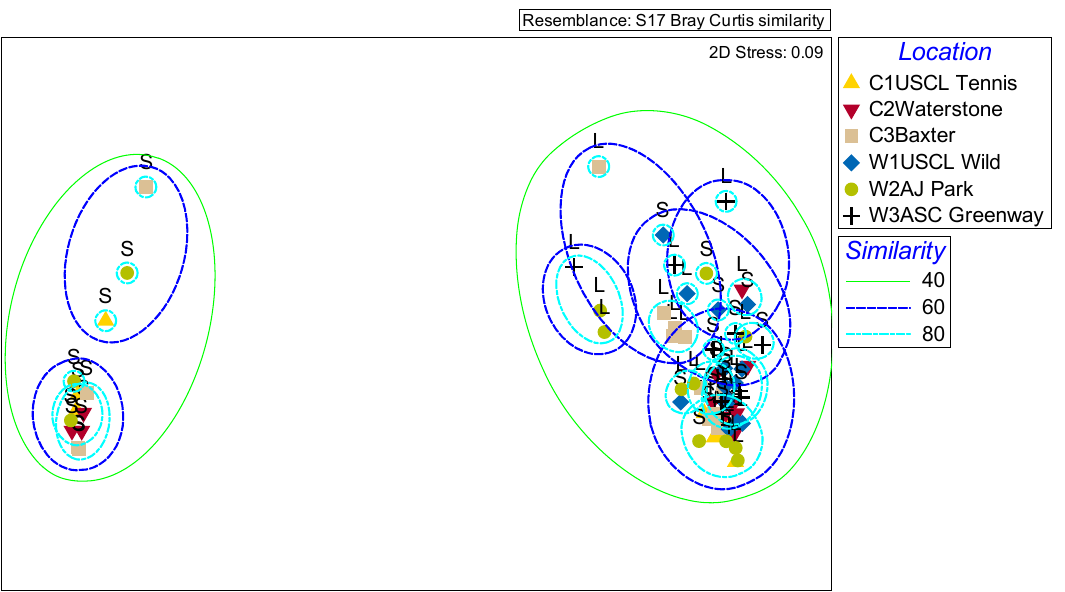
Figure 4. Non-metric multidimensional scaling plot of the relative proportions of all floral volatiles emitted by L and S flowered morphs based on the Bray-Curtis dissimilarity index (stress = 0.09). Population locations are indicated by di ff erent symbols. The lines around the two groups indicate similarity percentages based on cluster analysis comparing the overall scent profiles.